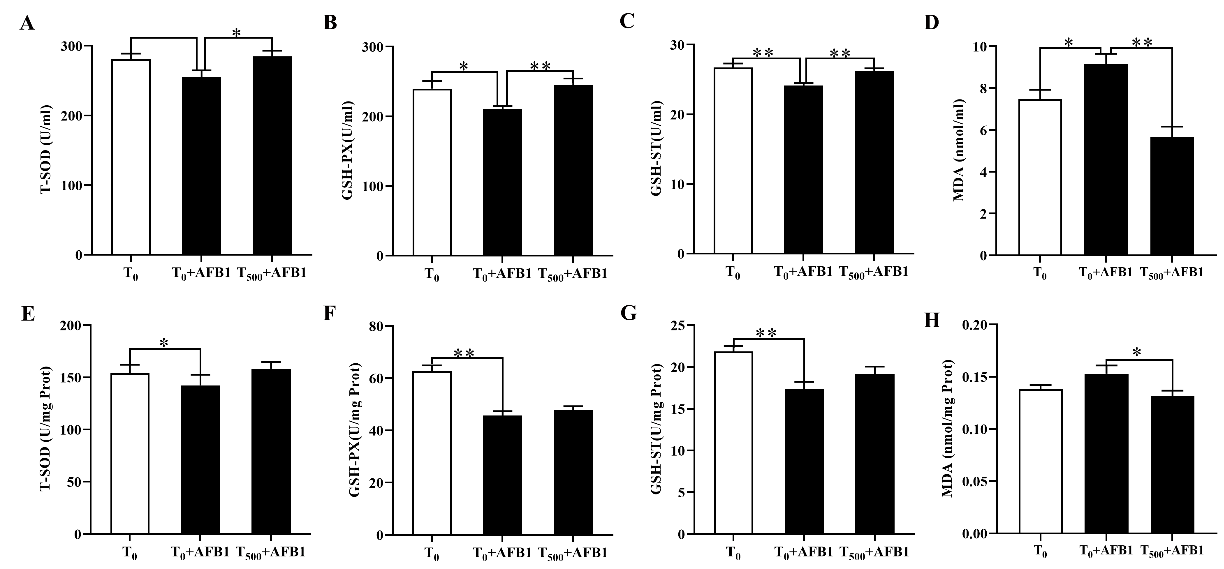
Figure 3. Antioxidant capacity of the plasma and ileum of ducks ( Anas PlatyrhynchosI ) exposed to AFB1 at 70 days. T 0 :